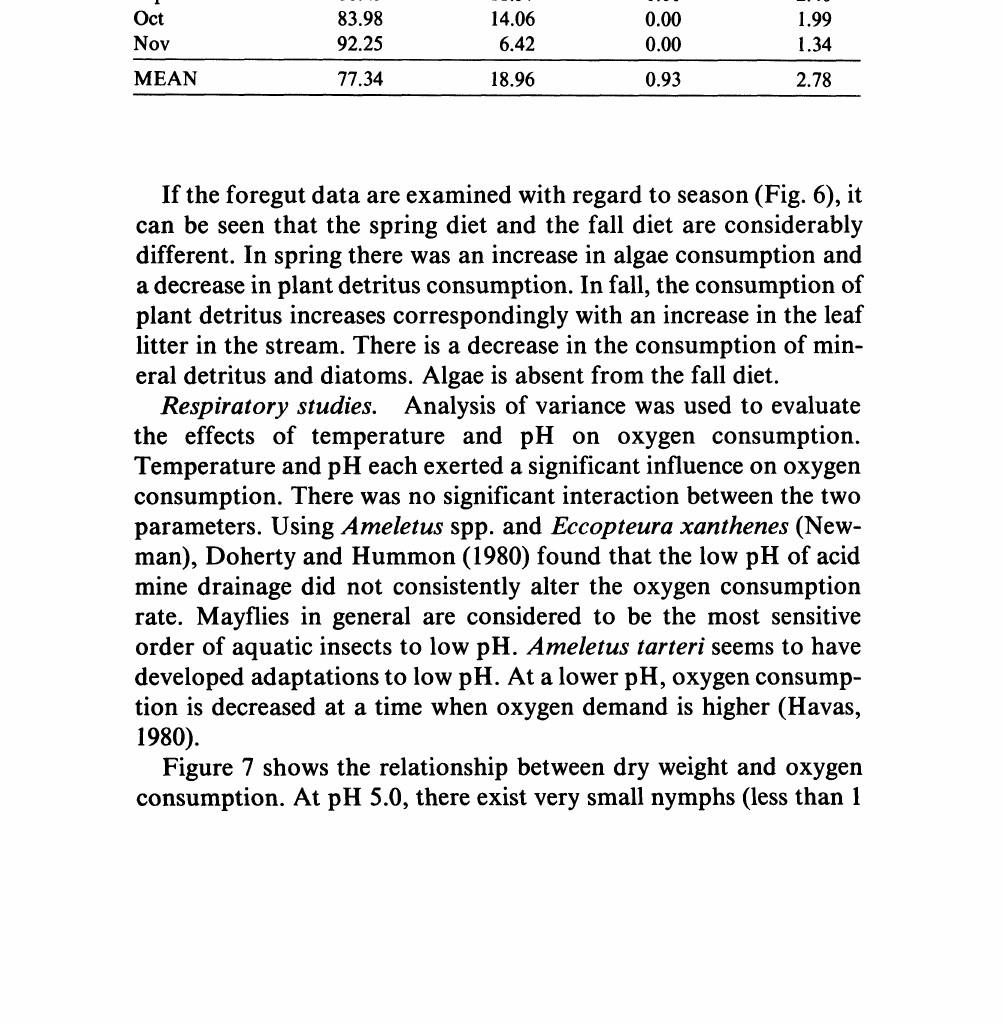
Table 1. Relative foregut contents of nymphal Ameletus tarteri at Carpenter Run, November 1986-November 1987. Month Plant Mineral Algae Diatoms Nov 71.12 21.71 0.00 7.17 Dec 75.87 21.16 0.00 2.97 Jan 66.58 26.55 0.00 6.87 Feb 77.24 21.57 0.00 1.19 Mar 74.53 15.88 1.42 8.17 Apr 66.87 21.33 9.11 2.69 May 65.76 33.40 0.63 0.21 Jun 74.35 24.22 0.00 1.43 Jul 77.93 20.88 0.00 1.19 Aug 86.43 10.71 86.23 6.42 MEAN 77.34 18.96 0.93